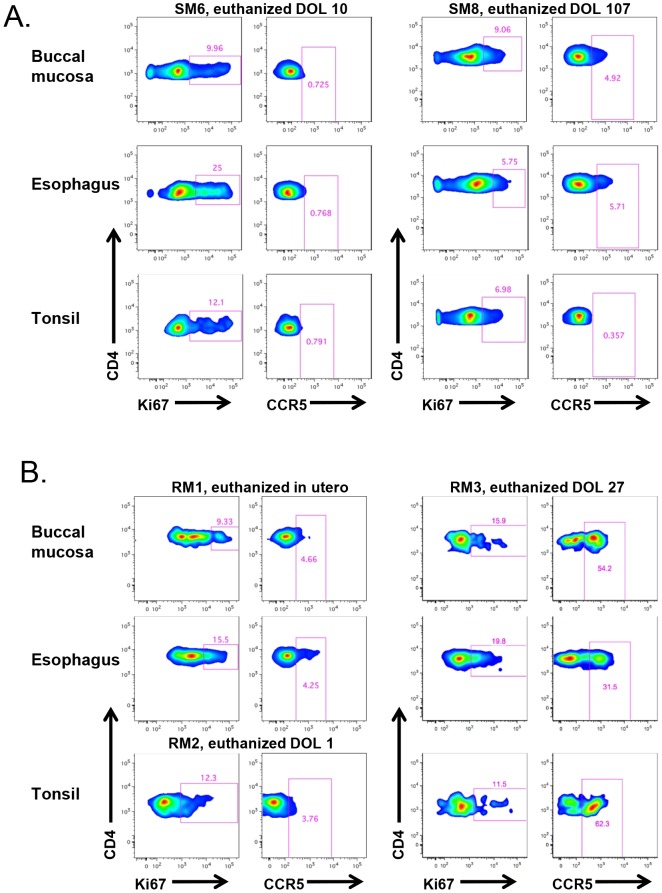
RM, but not SM, infants upregulate CCR5 expression on oral and upper gastrointestinal tract tissues early in life.The level of proliferation (Ki-67+) and SIV coreceptor expression (CCR5+) on CD4+ T cells isolated from the buccal mucosa, esophagus, and tonsils of representative SM (A) and RM (B) infants. CCR5 levels on CD4+ T cells remain low at these sites in SMs beyond three months of age, but are elevated before one month of age in RMs. DOL  =  day of life.